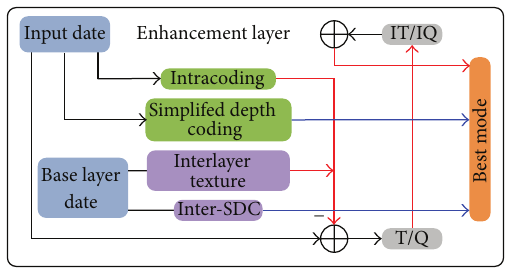
Figure 2: High-level block diagram of the encoder.